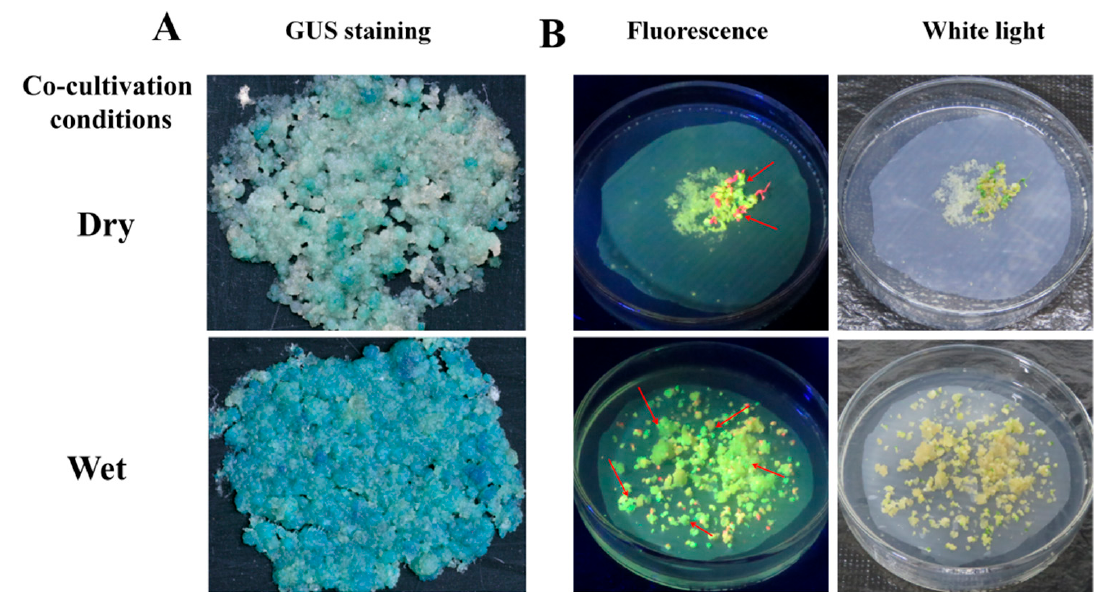
Figure 4. Stable expression of GUS in FECs ( A ) and GFP in cotyledons ( B ) under FECs with dry or wet treatment. ( A ) GUS staining of FECs. FECs were taken from the last time on GD medium plates. After GUS staining, pictures were taken under an ultradeep field microscope. ( B ) Cotyledons on MSN medium under white light and fluorescence. Red arrows point to somatic embryos with green fluorescence. Table 4. Effects of FECs with dry or wet treatment on cassava SC8 transformation.